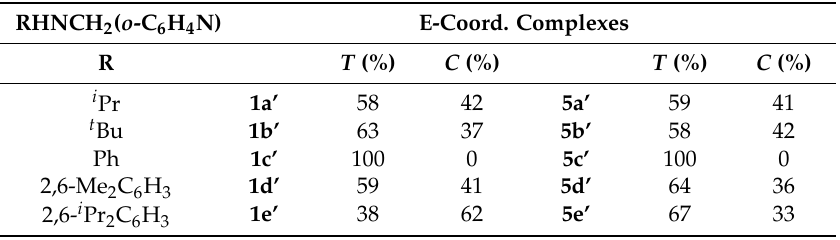
Table 3. The yields of E-coordinated Pd(II) species, from the reactions of 1 and ethylene in CDCl 3